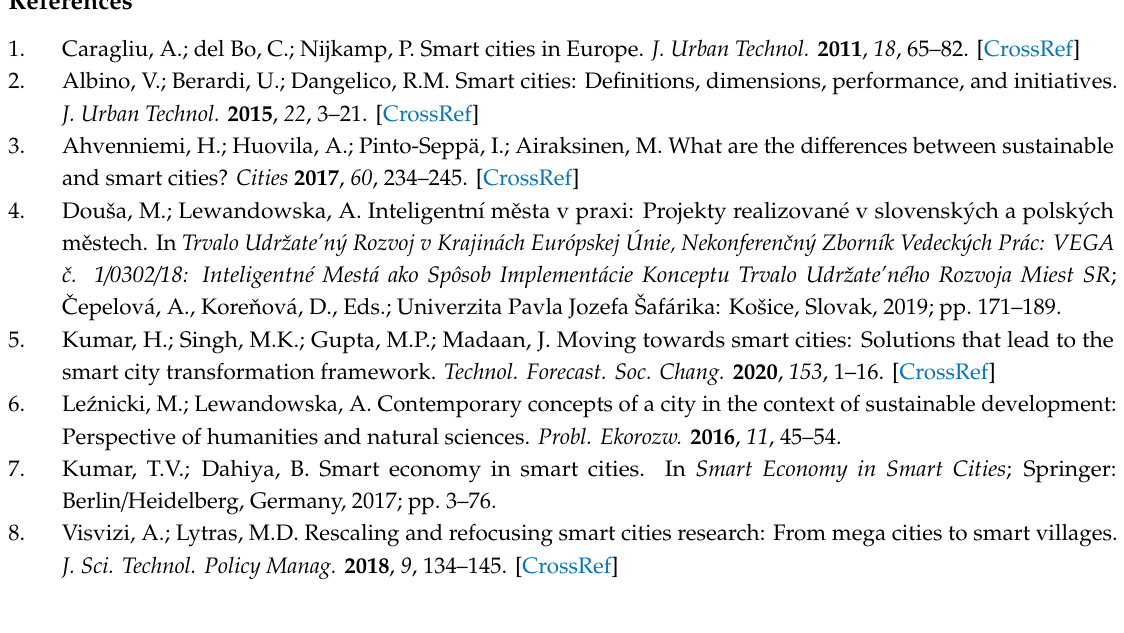
Table S1: RES in city development